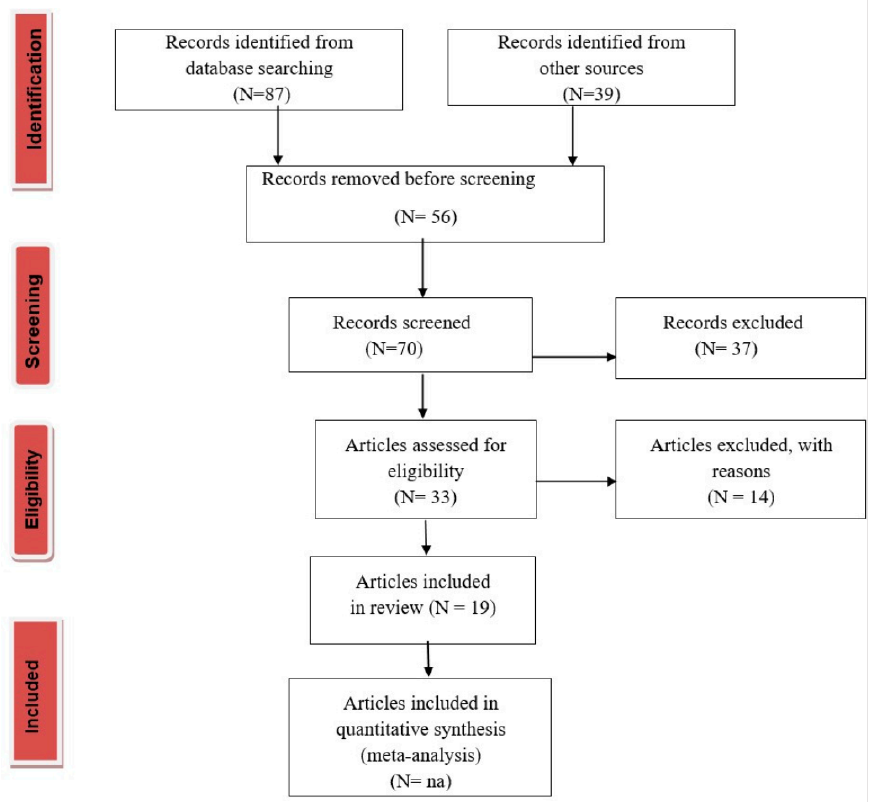
Figure 1. PRISMA flow diagram for literature search; na = not